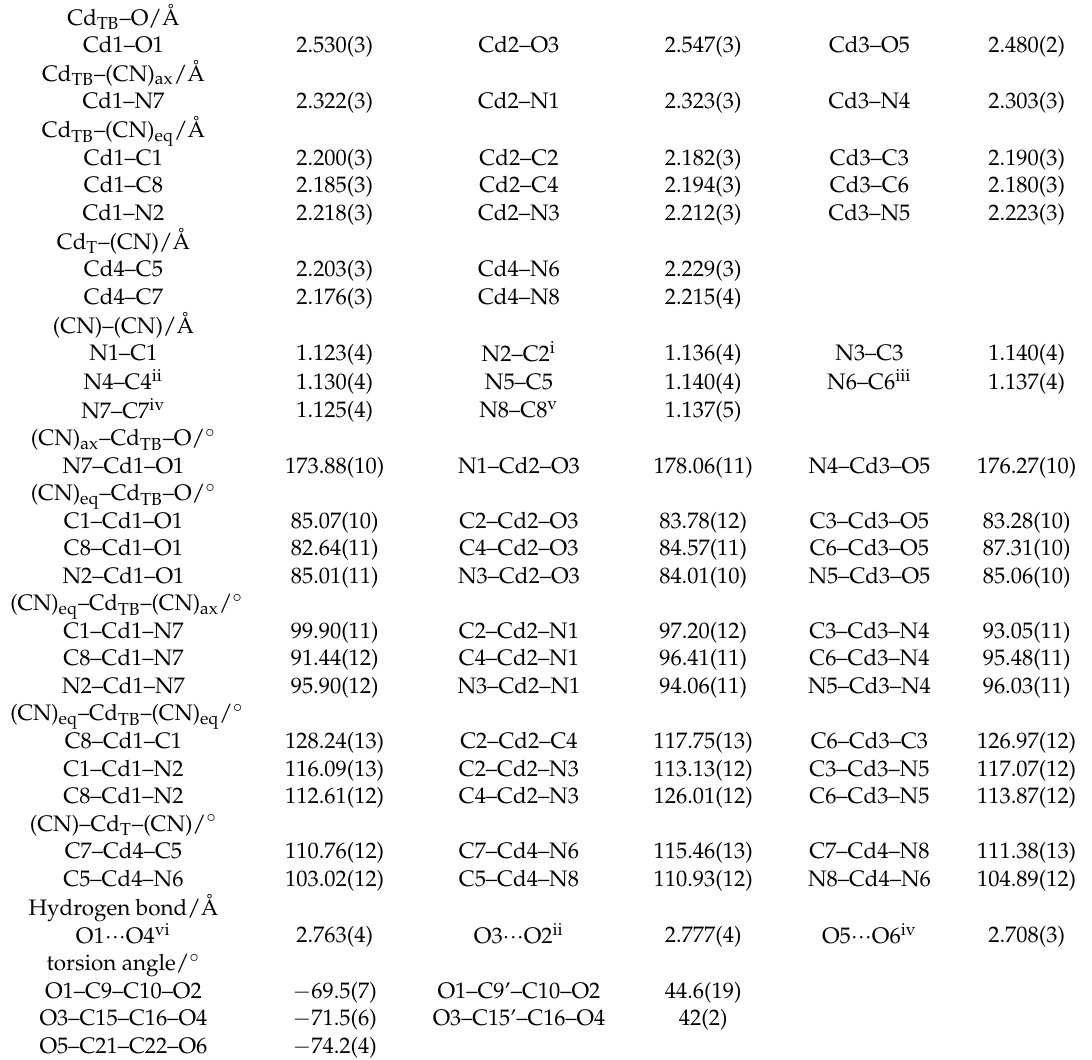
Table 3. Selected Parameters for II